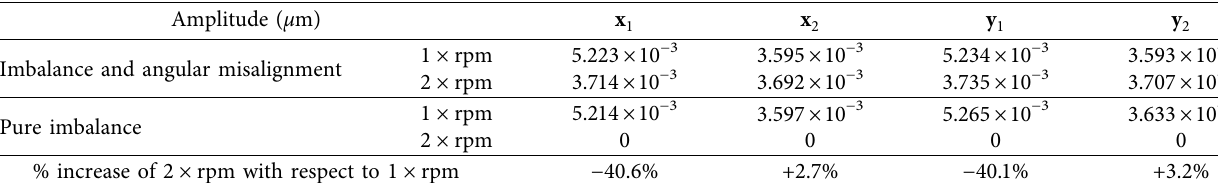
Figure 17: Effects of different degrees of angular misalignment on the vibration response. Table 8: Peak amplitudes of the fundamental and second harmonics in the radial direction under the combined action of imbalance and angular misalignment.